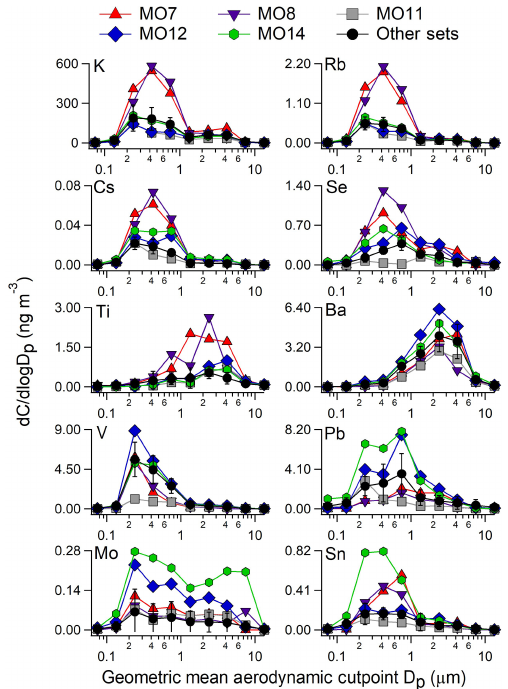
Figure 7. Selected elements that showed elevated concentrations during at least one of the highest aerosol events (MO7, MO8, MO12, or MO14). The concentrations from the lowest aerosol event (MO11) are also shown. The “other sets” category displays the av- erage ( ± 1 standard deviation) for the remaining seven